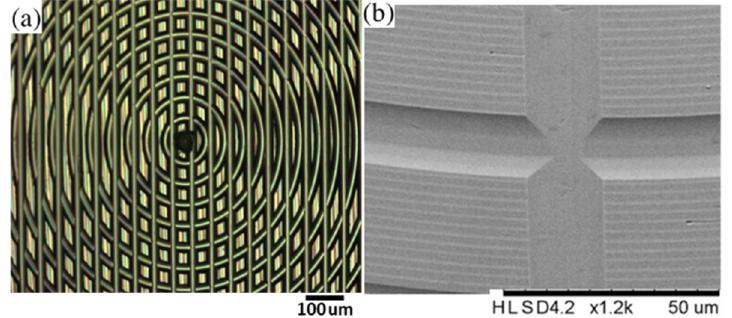
Figure 1. Polar microstructure observed with ( a ) Olympus BX 53M light microscope and ( b ) HITACHI TM3000 Scanning Electron Microscope.